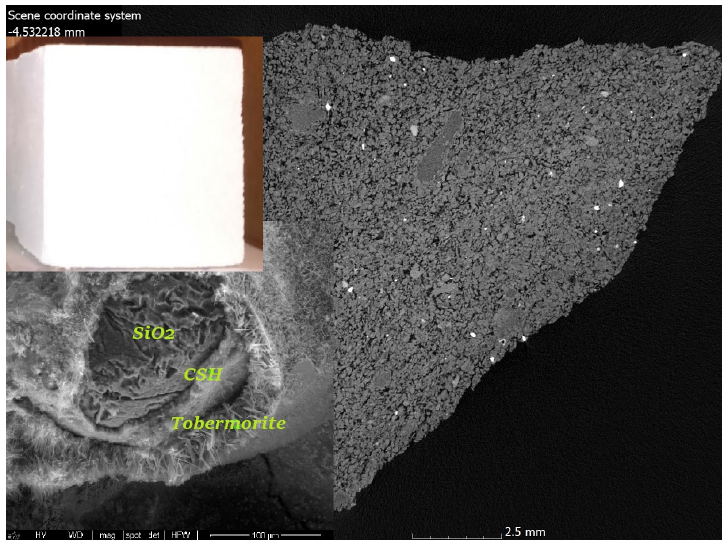
Figure 13. Computer tomography together with a photograph of the analyzed laboratory brick and an area of microstructure where a grain of quartz sand is visible.